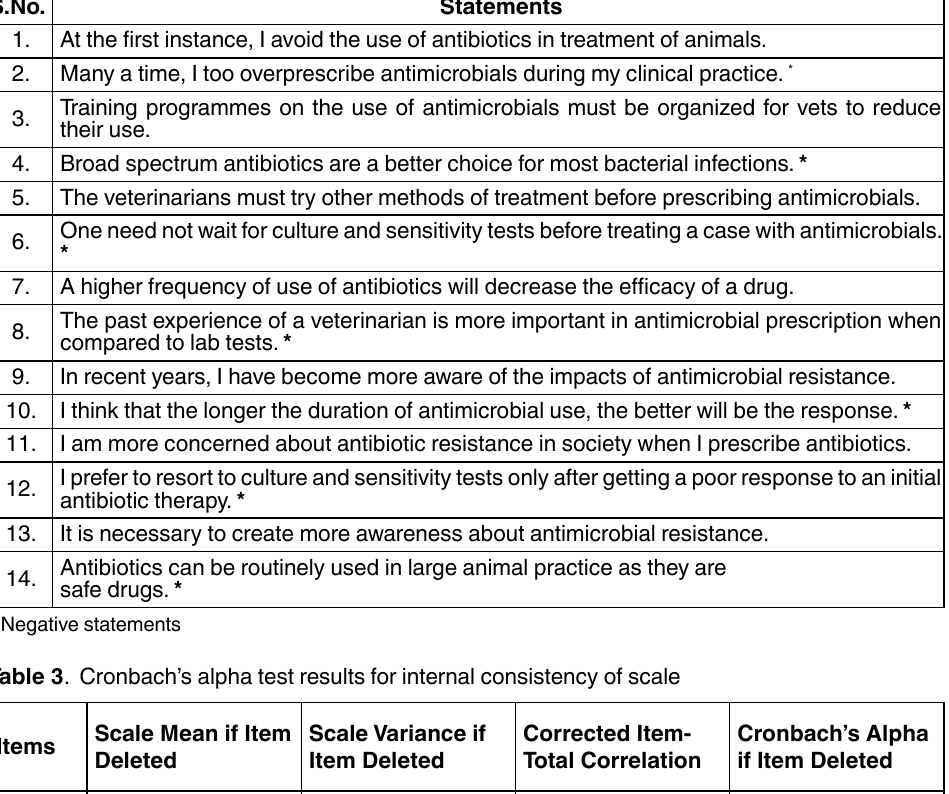
table 2 . Final scale on perception of veterinarians about antimicrobial use and resistance s.No.